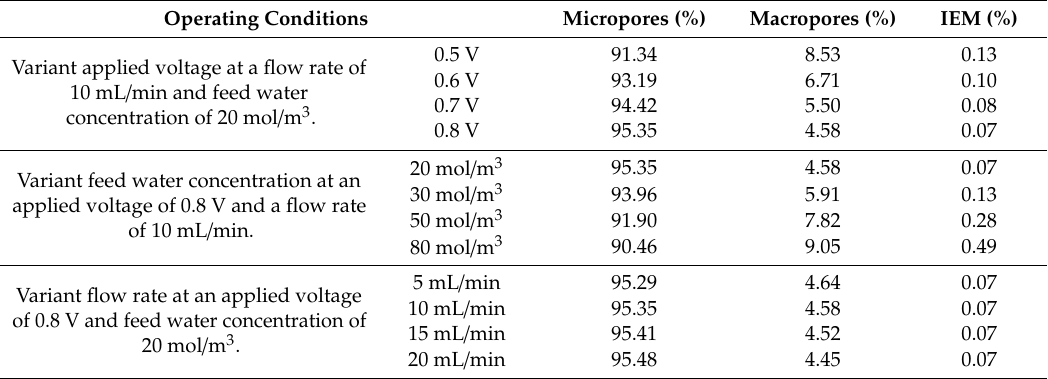
Figure 6. Adsorption isotherms of CDI and MCDI. The flow rate is 10 mL/min, and the applied voltage is 0.8 V. Table 2. Equilibrium adsorption percentage in micropores, macropores, and the IEM under varying operating